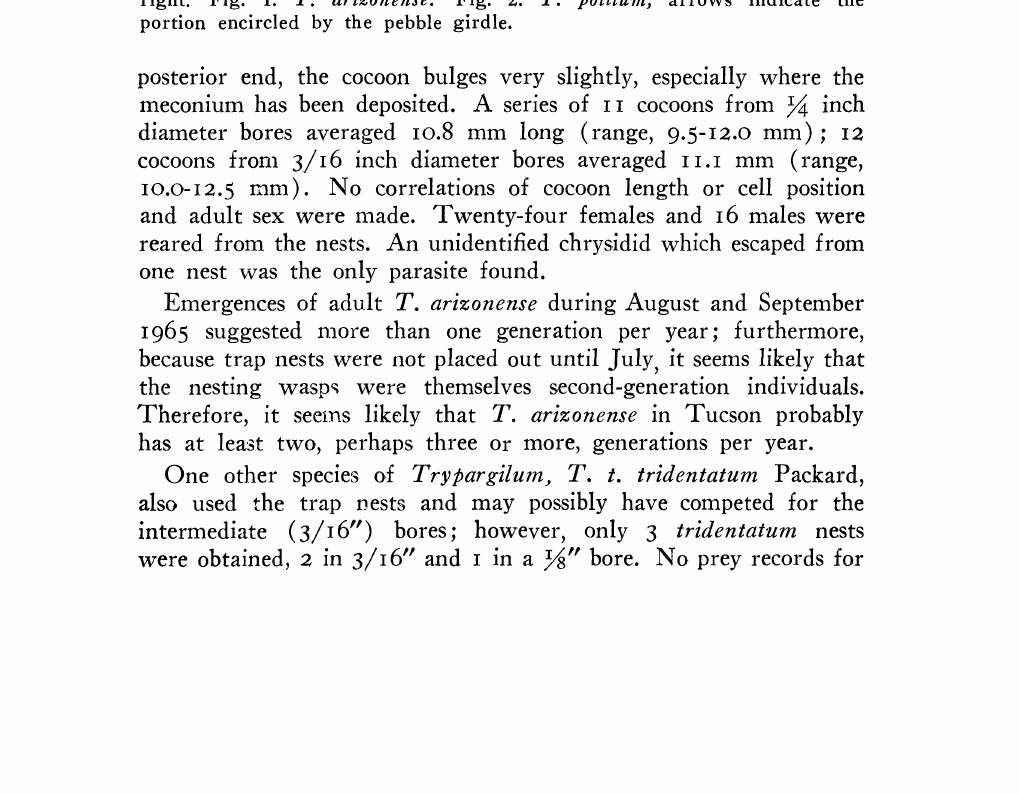
and 2. Diagrams o.t Trypargilum cocoons with the silken matrix removed; both drawn to the same scale. Anterior ends are at the right. Fig. 1. T. arizo’nense. Fig. 2. T. politum, arrows indicate the portion encircled by the pebble